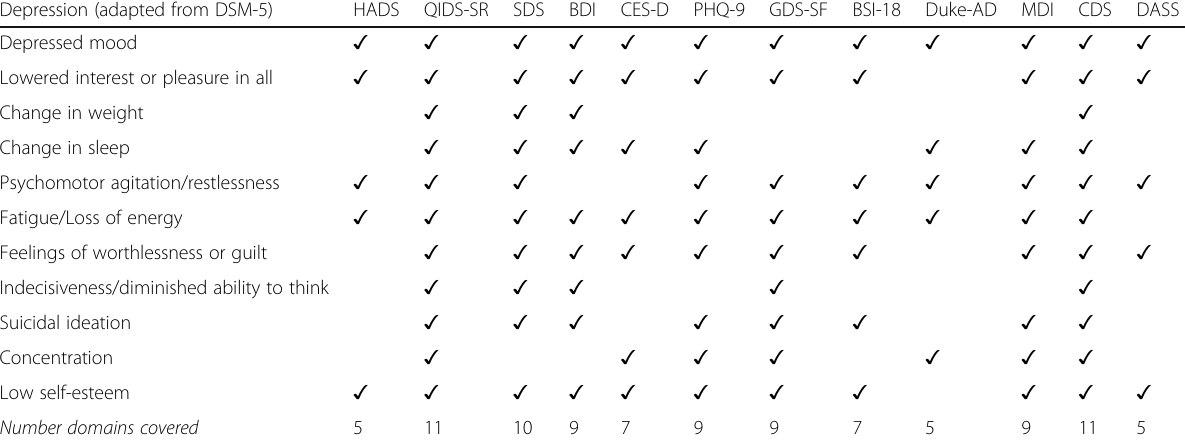
Table 2 Patient reported outcome measures of depression: content mapping Depression (adapted from